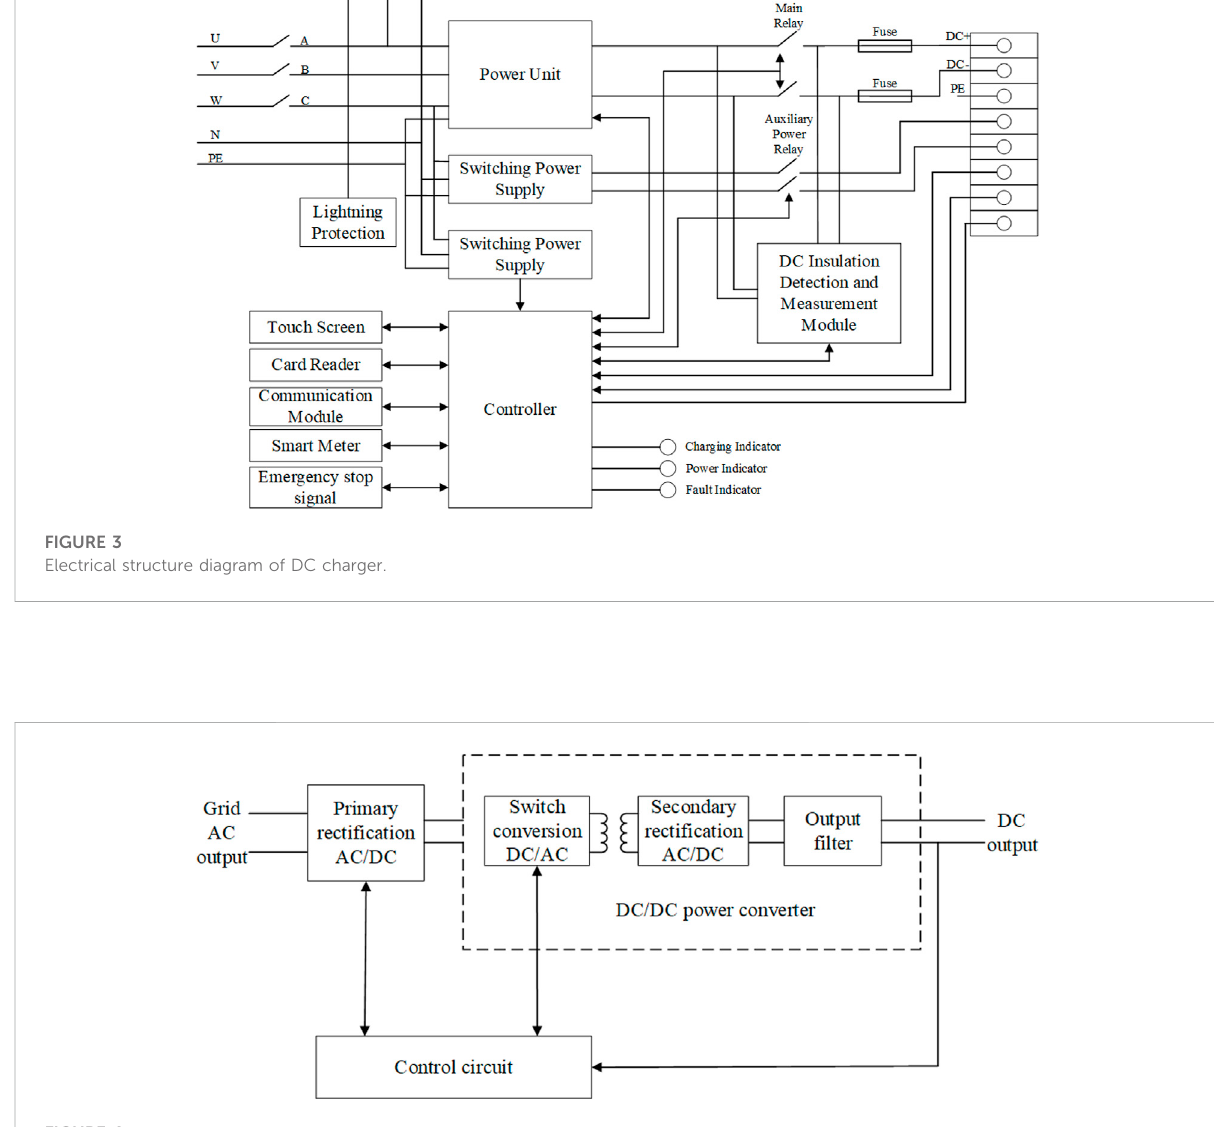
FIGURE 4 Basic structure diagram of DC charger power